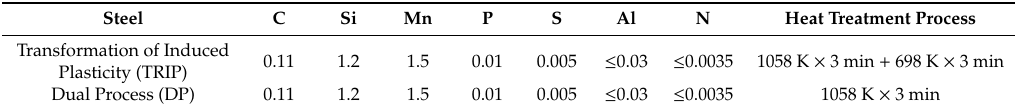
Table 1. Chemical composition of specimens (wt%).